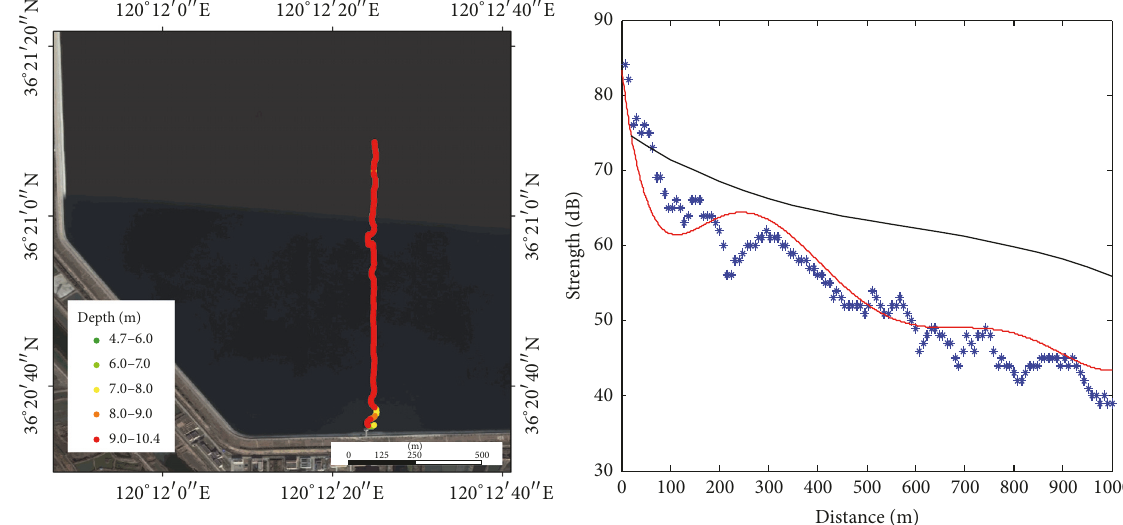
Figure 7: Mobile points strength